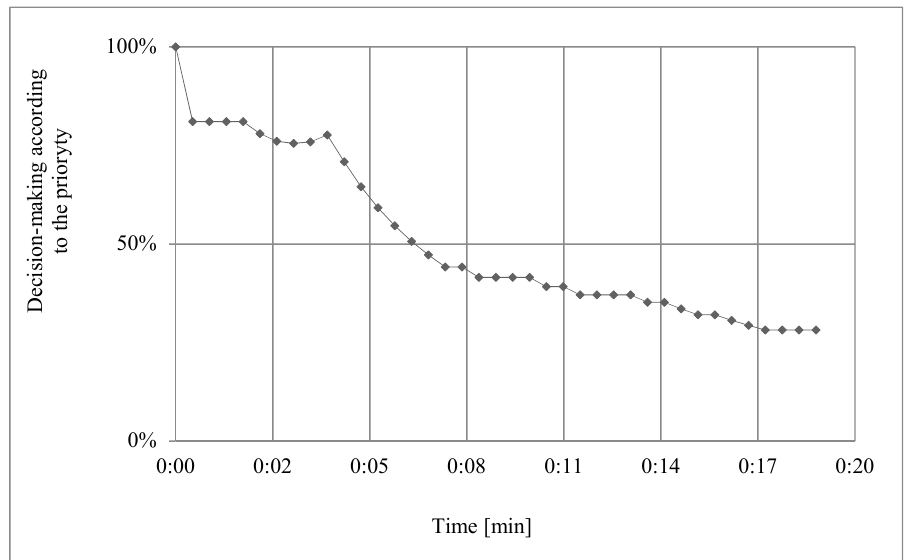
Figure 3. Graph of the probability of rational action taking against the duration of the simulation, in relation to scenario 1.